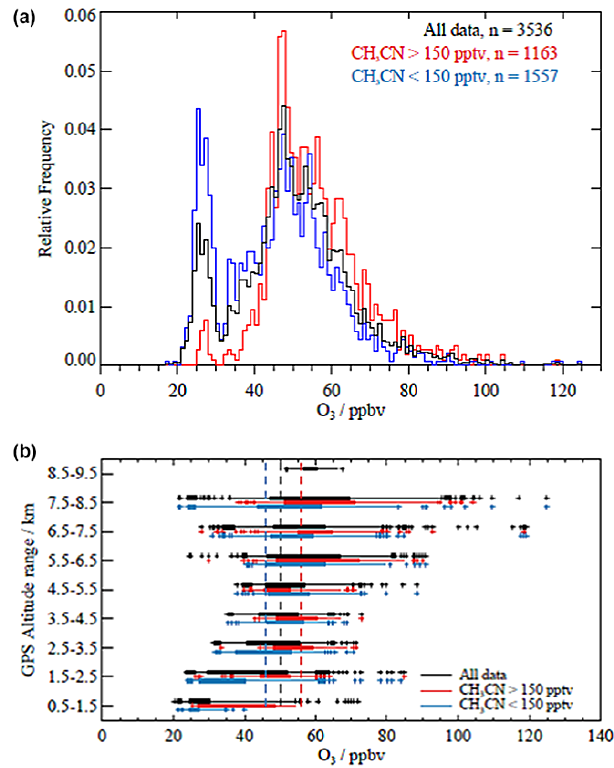
Figure 31. (a) Frequency distribution for ozone over the BORTAS (Palmer et al., 2013) flights, the black line are the measured mixing ratios, where the red line shows the distribution of measurements identified as biomass burning plumes using a threshold of CH 3 CN mixing ratios greater than 150pptv, and the blue line shows mea- surements made in air masses with CH 3 CN mixing ratios less than 150pptv. (b) The same data plotted as box-and-whisker plots (solid boxes show the range of the 25th to 75th percentiles and whiskers show the range of the 5th to 95th percentiles, with outliers shown as plus symbols) (GPS) altitude profile (Parrington et al.,